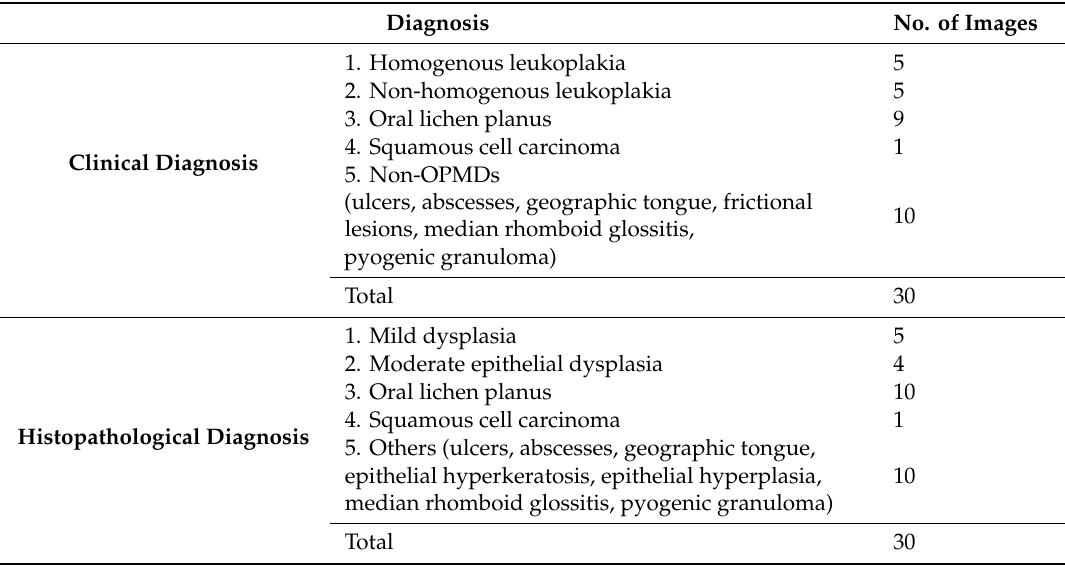
Table 1. Clinical diagnosis and histopathological diagnosis of oral potentially malignant disorders (OPMDs) in the selected database.